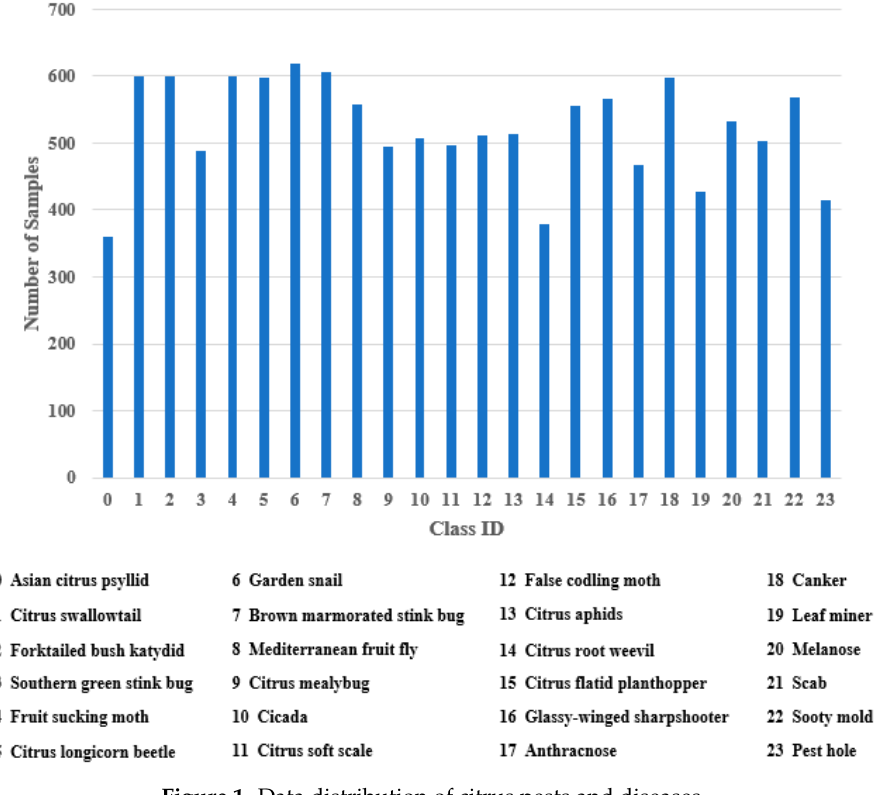
Figure 1. Data distribution of citrus pests and diseases.